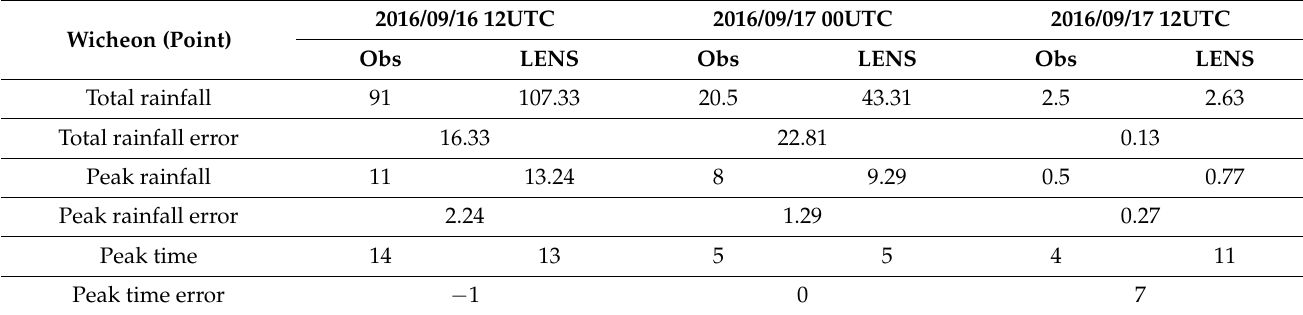
Table 5. LENS point data from 2016/09/16 12UTC to 2016/09/17 12UTC.